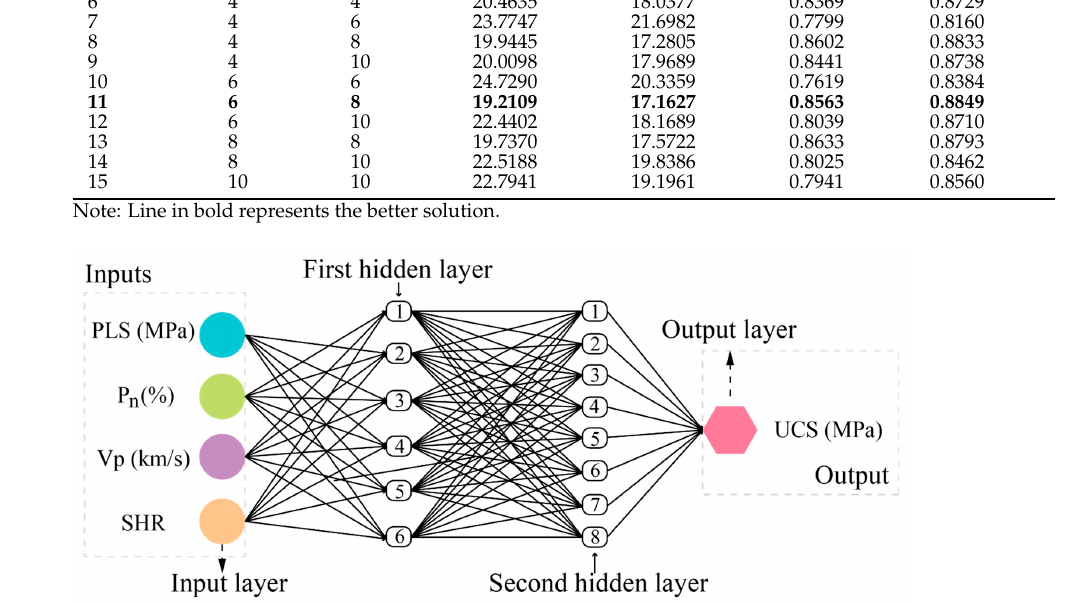
Figure 8. Considered BPNN architecture.